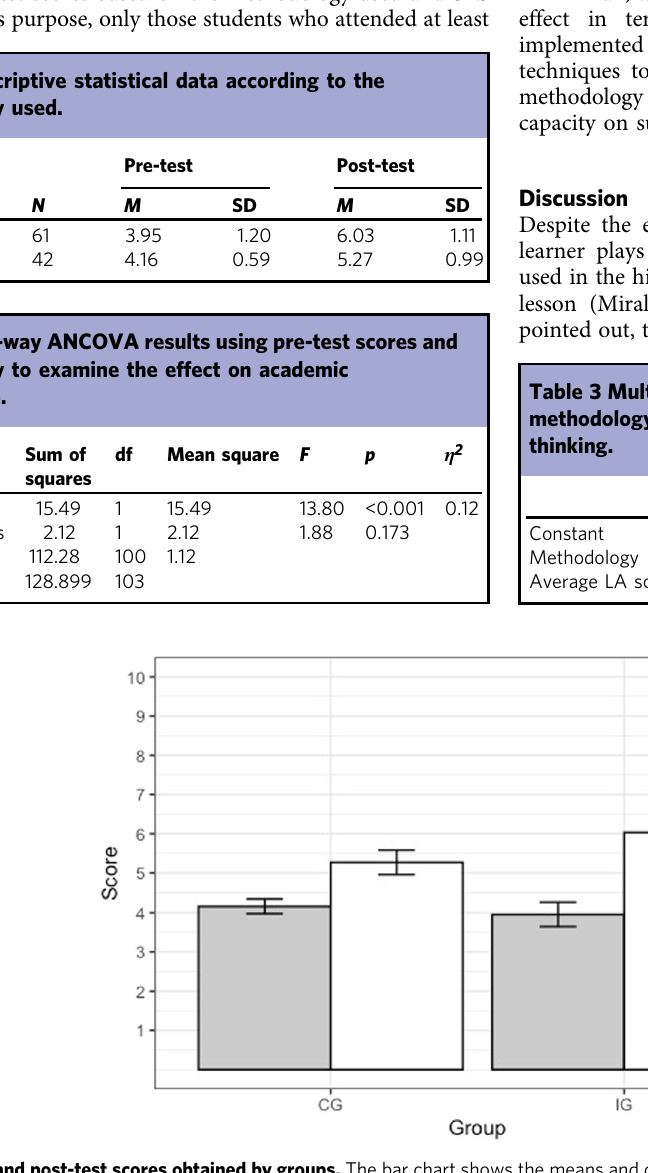
Fig. 3 Pre-test and post-test scores obtained by groups. The bar chart shows the means and con fi dence intervals for both the control group (CG) and the intervention group (IG) before and after the intervention. HUMANITIES AND SOCIAL SCIENCES COMMUNICATIONS| (2023) 10:44